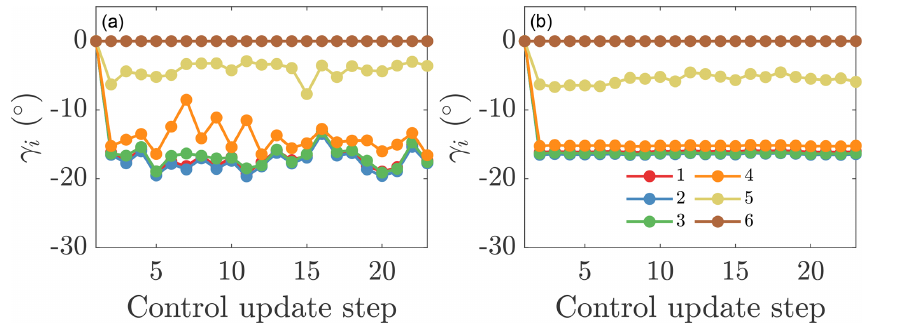
Figure E1. Yaw misalignment angles for each turbine in the wind farm for online control using (a) the initial parameters to initialize the next state (ND141) and (b) static state estimation parameters (ND142) for wind farm alignment at 14 ◦ .